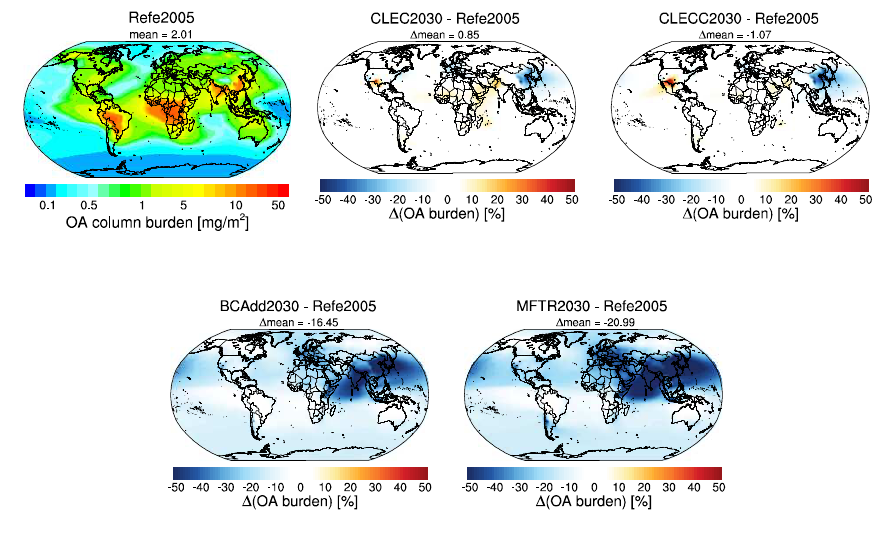
Figure 3. Like Fig. 2 but for organic aerosol (OA)